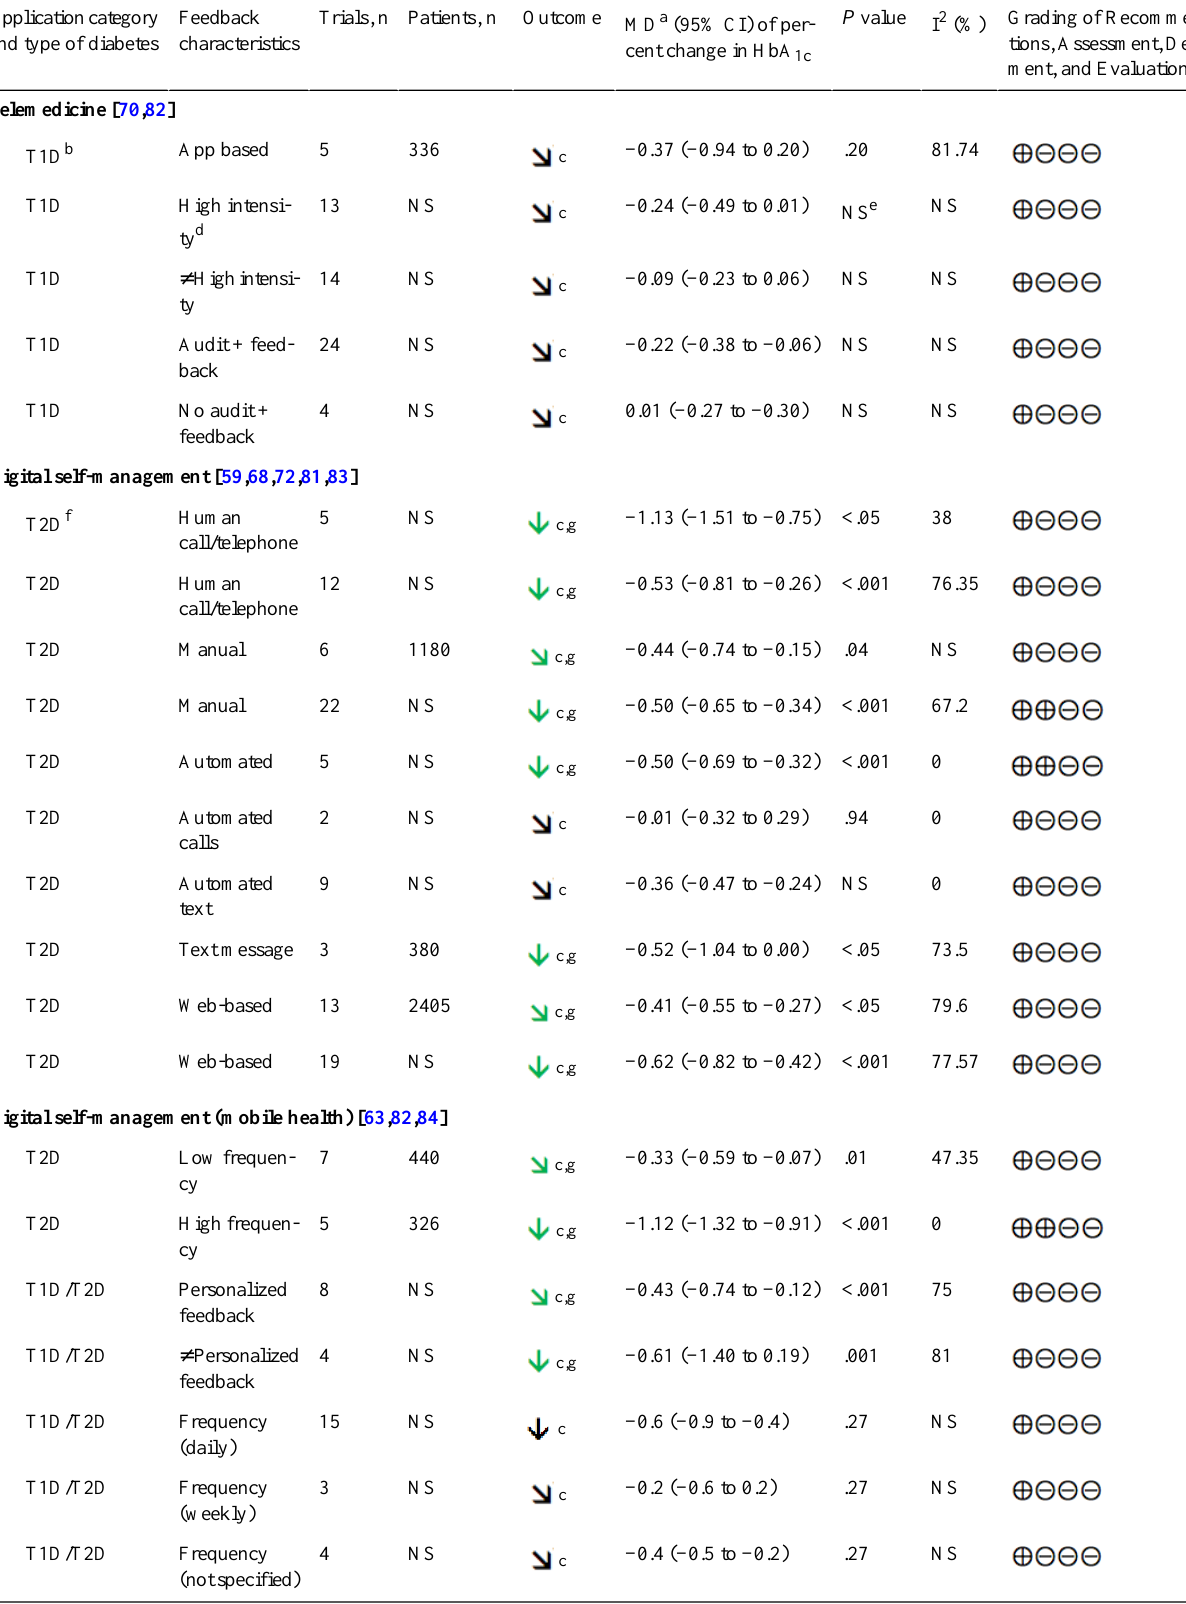
Table 4. Effectiveness of telemedicine on glycated hemoglobin in patients with diabetes, according to feedback mode, frequency, and intensity.